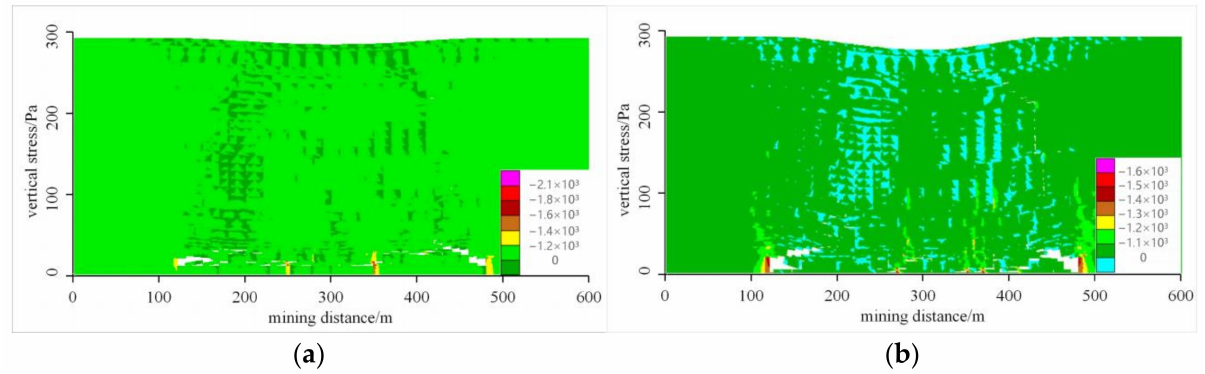
Figure 10. Vertical stress of the overburden under mining at the end of the first ( a ) and second ( b ) slice extraction.